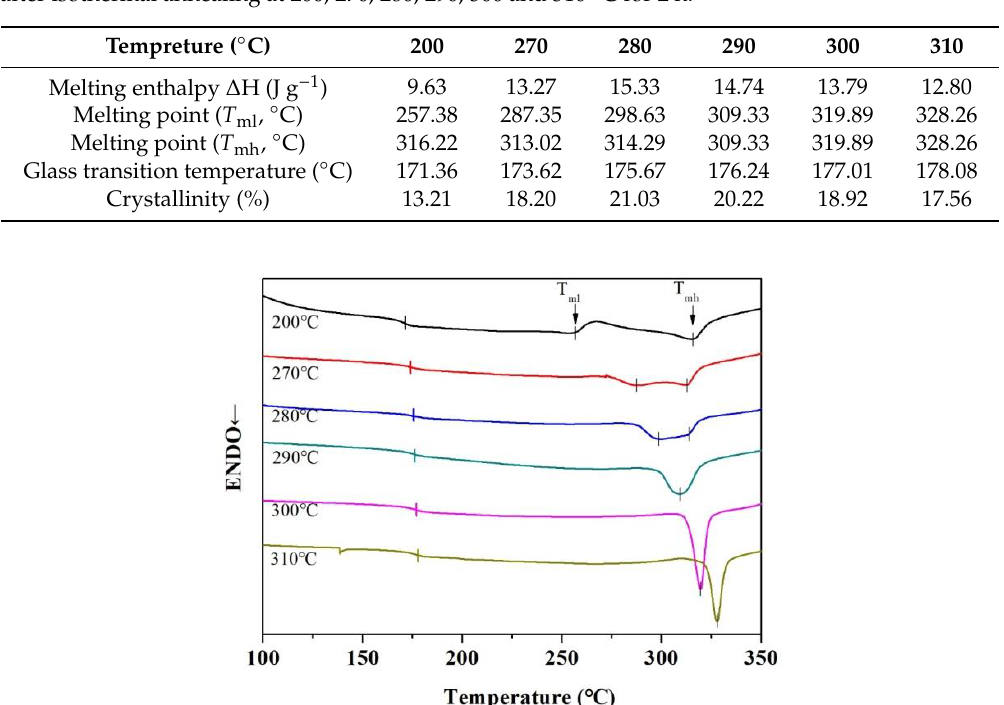
Table 1. The physical parameter values of BT@ZnPc-GO-1 / PEN films with 15 wt % BT@ZnPc-GO-1 after isothermal annealing at 200, 270, 280, 290, 300 and 310 ◦ C for 2 h.